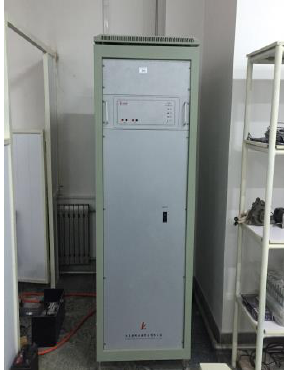
Figure 2. Test equipment uC-ZS08.